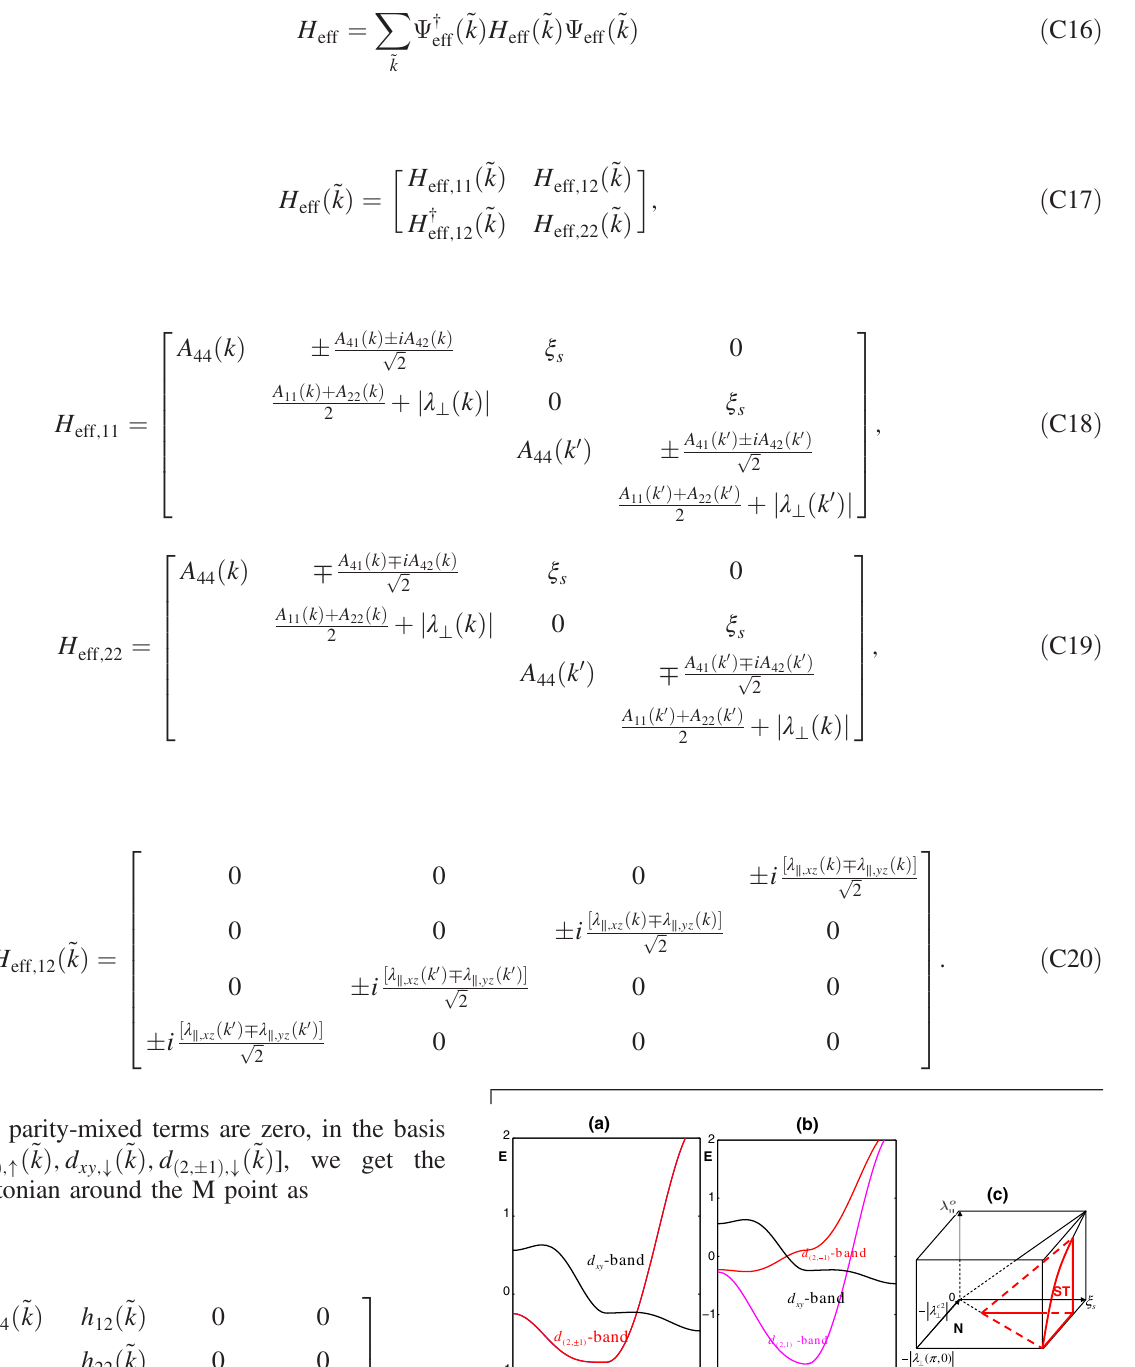
FIG. 11. Panels (a) and (b) show the band inversion that occurs around M point from the normal phase (a) with λ o ⊥ ¼ 0 . 0 , λ nn 0 . 0 , λ o 0 . 0 , and ξ 0 , to a topological phase with λ o ⊥ ¼ ⊥ ¼ ∥ ¼ s ¼ − 0 . 12 , λ o 0 . 0 , and ξ 0 . Here, we show the 0 . 5 , λ nn ⊥ ¼ ∥ ¼ s ¼ parity-even part. The parity-odd part has a similar picture. (c) The phase diagram as a function of λ ⊥ ð π ; 0 Þ , λ o ∥ , and ξ for s λ π ; 0 Þ < 0 . Here, ST and N label the strong topological phase ⊥ ð and the normal trivial